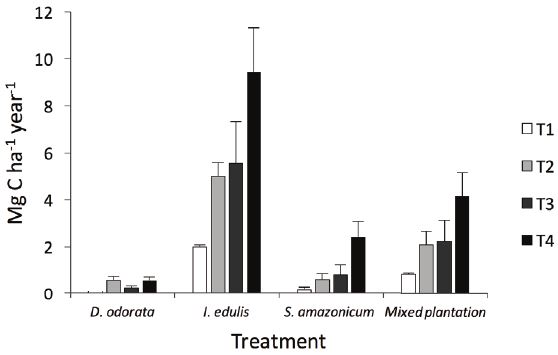
Figure 1 - C sequestration potential of the three tested species and a mixed plantation under the diff erent fertilization treatments based on the total biomass (aboveground and root biomass). T1 – no fertilization, T2 – chemical fertilization, T3 – organic fertilization, and T4 – organic and chemical